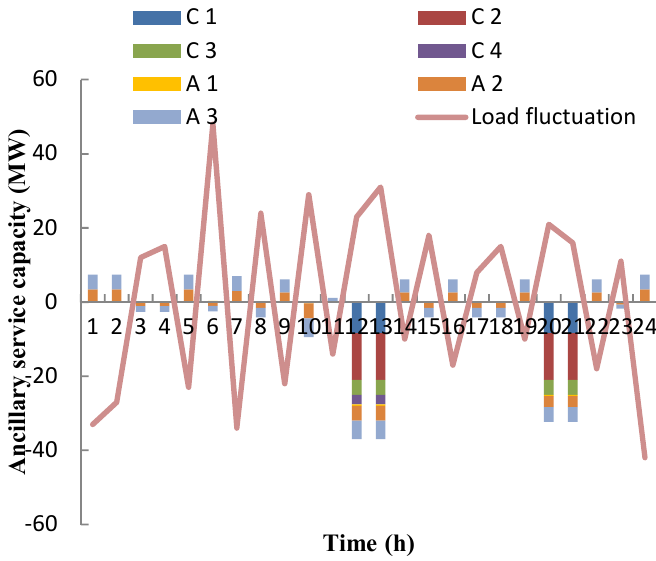
Figure 9. Power deviation for industrial users providing AS in real-time